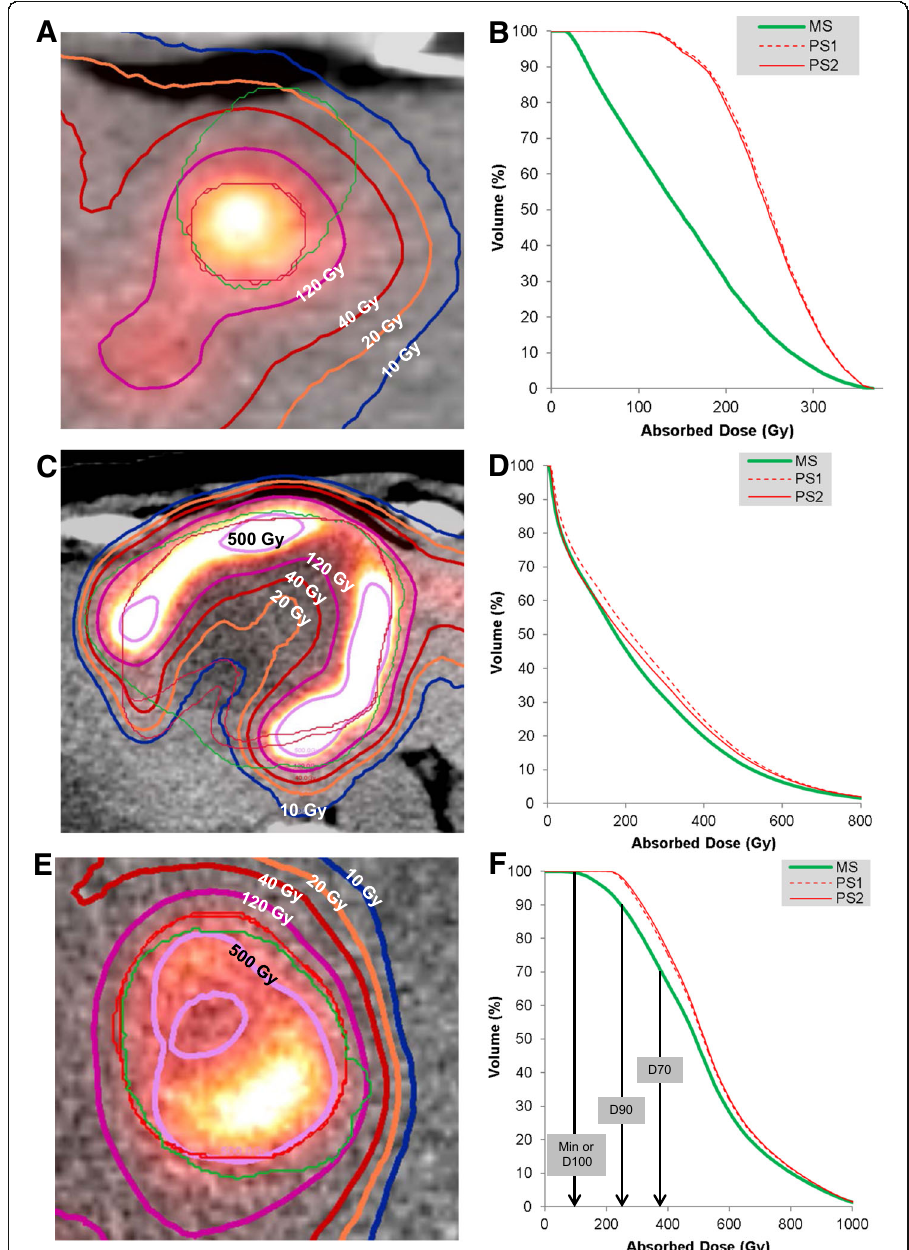
Fig. 4 The absorbed isodose contours (thick lines) with morphologic (thin green lines) and PET-based (thin red lines) segmentations in ( a ), ( c ), and ( e ) with the corresponding lesion DVHs in ( b ), ( d ), and ( f ), respectively. These are the same lesions represented in Fig.